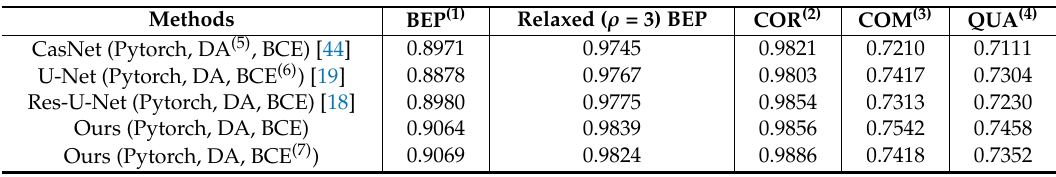
Table 4. Evaluation results on NLPR road datasets.